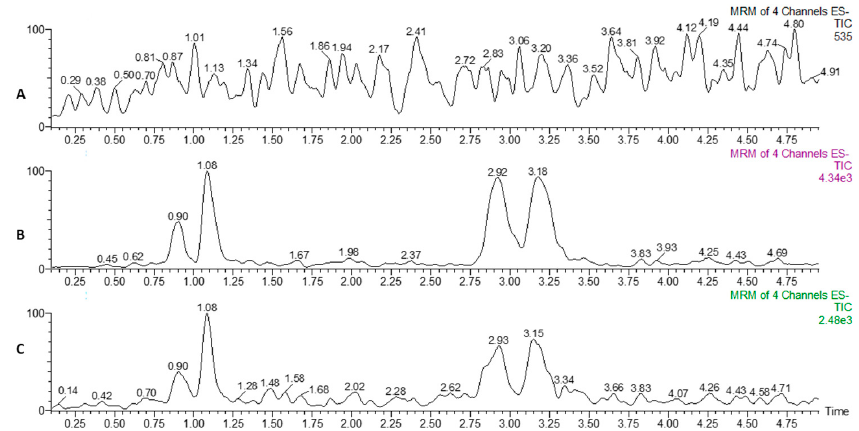
Figure 3. Representative chromatograms of a sample extracted from kidney ( A ); liver ( B ); and intestine ( C ). Table 4. Concentration of each analyte in sea lamprey liver, kidney, and intestine.